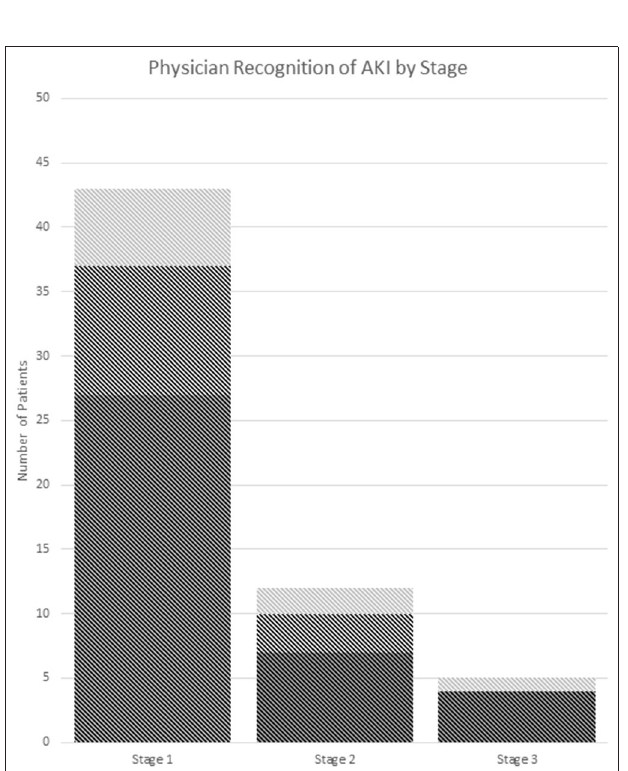
FIGURE 3 | Recognition of AKI by stage. (A) Dark gray: no documentation. (B) Medium gray: documentation of abnormal labs. (C) Light gray: documentation of the presence of AKI or elevated Cr in assessment and/or plan. AKI stage is chosen by the highest stage met of any the pRIFLE, AKIN, or KDIGO criteria.